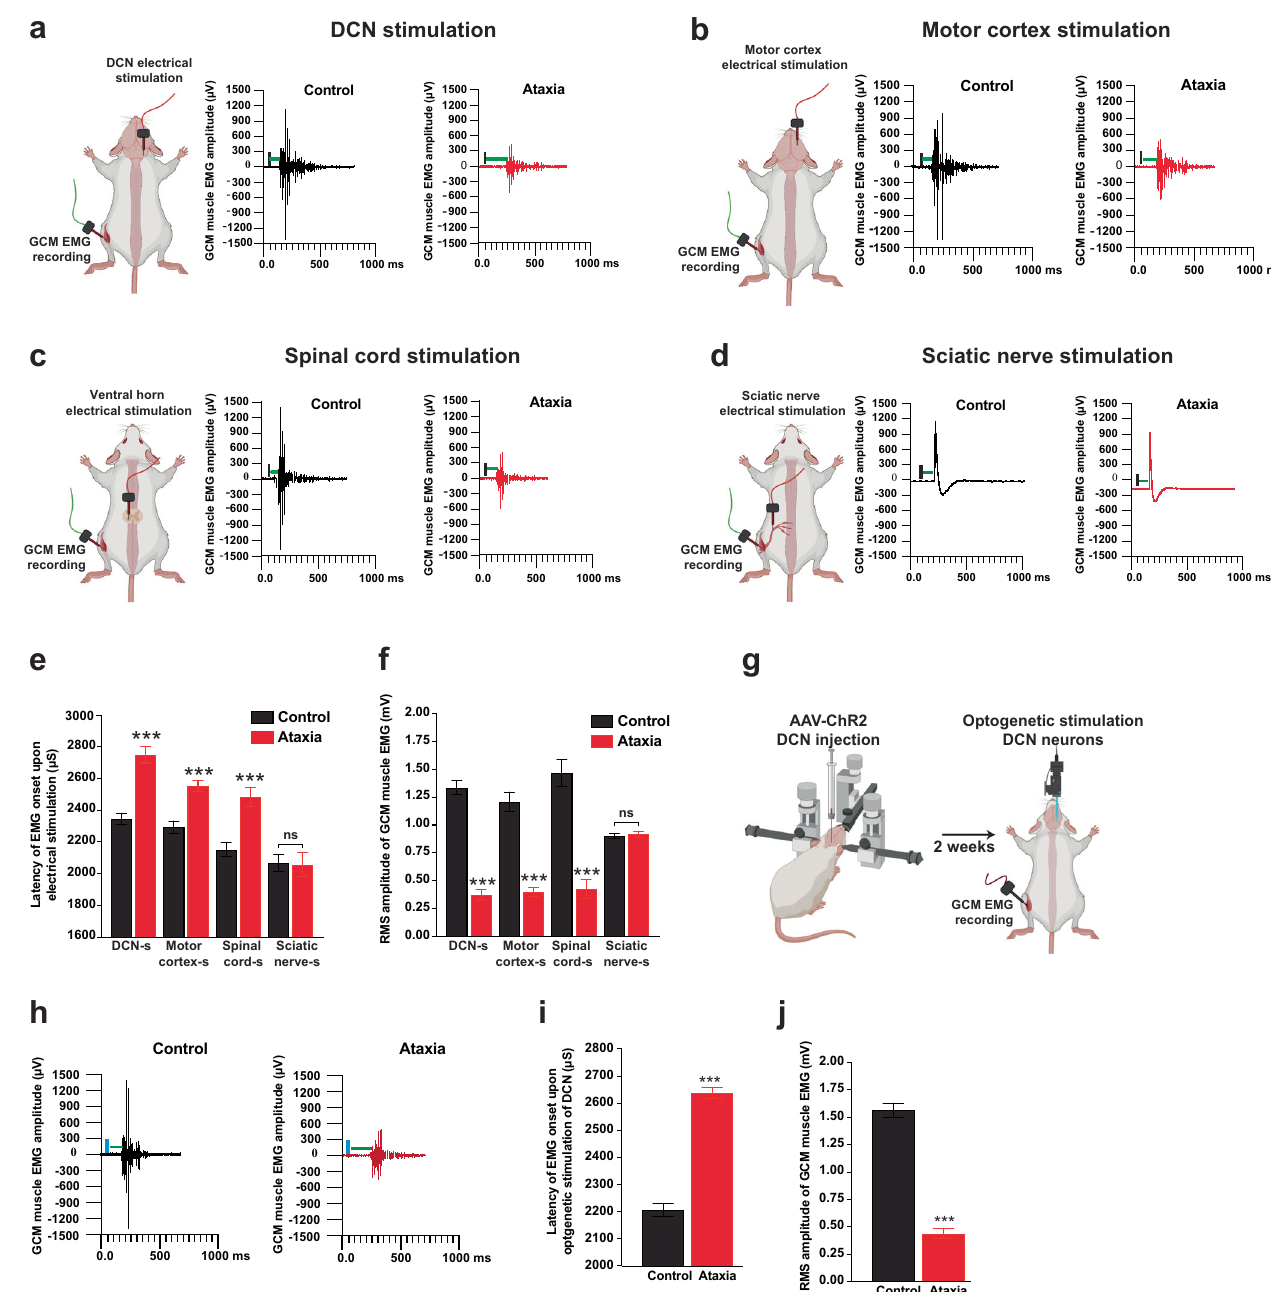
Fig. 3 Impairment of cerebellothalamocortical motor circuitry in ataxia mice. a – d Electromyography (EMG) responses evoked by deep cerebellar nuclei (DCN), motor cortex, spinal cord and sciatic nerve stimulations were recorded from gastrocnemius (GCM) muscle in anesthetized mice. The vertical black line marks the time of electrical stimulations and the horizontal green line represents the latency of EMG onset. e Ataxia mice showed signi fi cant increase in latency of EMG onset. f Spontaneous EMG activities reduced signi fi cantly in ataxia mice with DCN, motor cortex, and spinal cord stimulations. By contrast, the compound muscle action potential (CMAP) amplitudes evoked by sciatic nerve stimulation, remained unchanged and were comparable between ataxia and control mice. g and h EMG activities of GCM muscle upon optogenetic stimulation of AAV2-mediated channelrhodopsin-2 (ChR2)-transduced DCN neurons. i and j Similar to the studies on electrical stimulation of DCN, ataxia mice showed a signi fi cantly longer latency of EMG onset than control mice and a reduction of CMAP amplitude upon optogenetic stimulation of DCN. n = 6 – 8 mice per group were used in electrical and optogenetic stimulations. About 25 – 30 EMG responses per mouse were used for CMAP amplitudes and latency analysis. Values represent the mean ± SEM; *** P < 0.001, unpaired Student ’ s t -test. ns non-signi fi cerebellar circuitry in ataxia mice (Supplementary Fig. 7a). Sorted immediately after SNC could recover motor function in ataxia DCN neuronal spikes showed that there were signi fi cant increases mice. First, we recorded neural fi ring in the interposed nucleus of in mean neural fi ring rate (Supplementary Fig. 7b) and a number DCN in freely moving mice and observed intense activity spikes of bursts (Supplementary Fig. 7c), and a decrease in the interspike with aberrant and irregular waveforms indicating abnormal